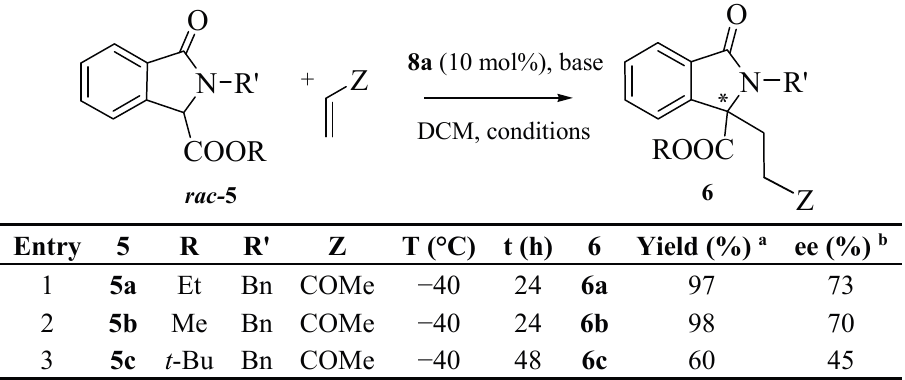
Table 3. Scope of phase transfer catalyzed asymmetric Michael